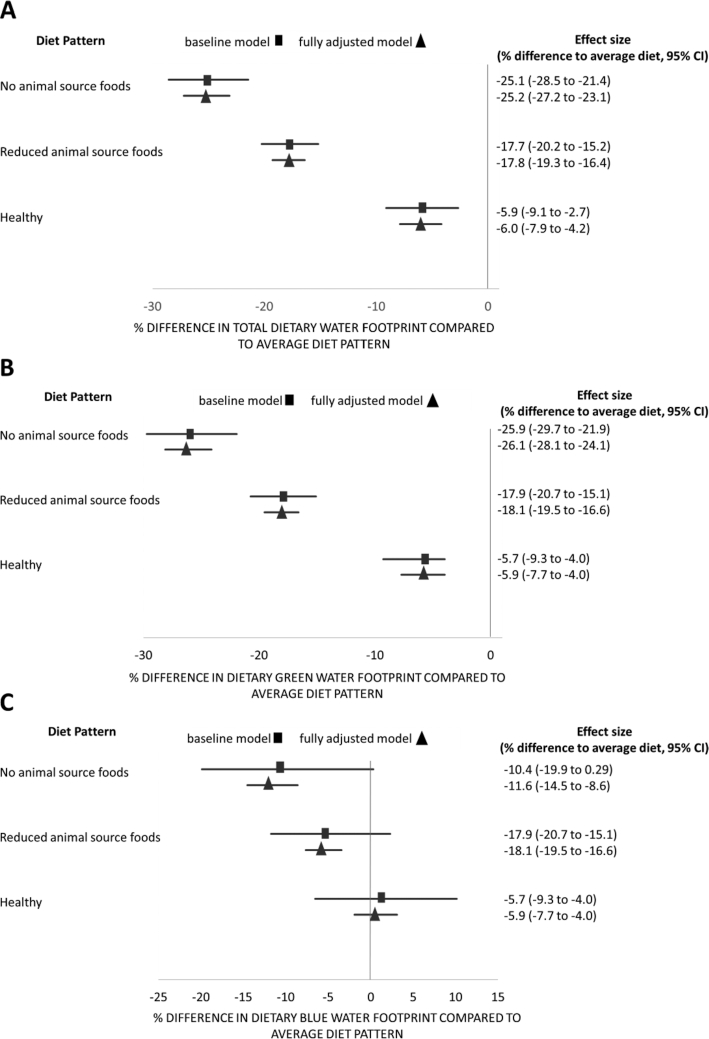
Forest plots with coefficient estimates from the mixed effects regression of diet pattern and (A) total WF, (B) green WF, and (C) blue WF. Values represent the percentage differences (95% CI) in dietary WF for each of the 3 dietary patterns compared with the average dietary pattern; n studies = 32 (total), 20 (green), and 24 (blue); n estimates = 1933 (total), 1834 (green), and 1895 (blue). In all graphs the 0 line represents the “average” dietary pattern. Study identifier was used as a random effect, and the fully adjusted model included study location, scale, and source of WF data. WF, water footprint.